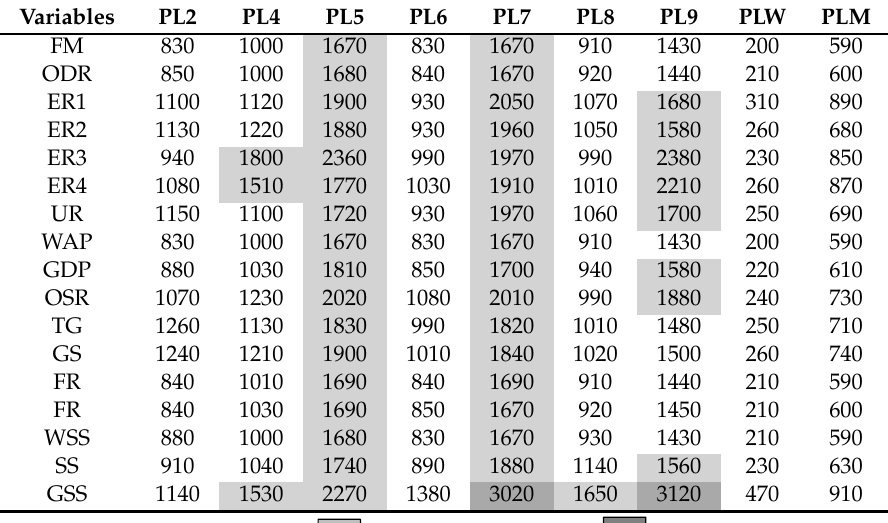
Table 5. Herfindahl–Hirschman Index (HHI) coe ffi cient for four categories of health determinant (SDH).